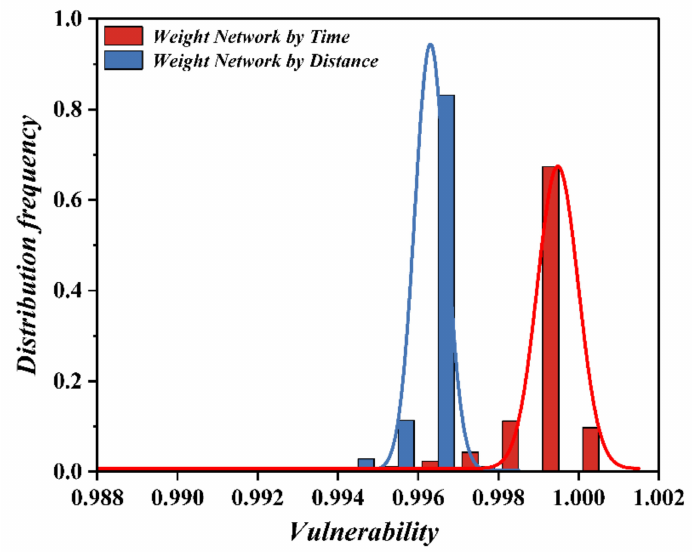
Figure 11. The histogram and Gaussian fitting curve of road vulnerability frequency distribution under two network